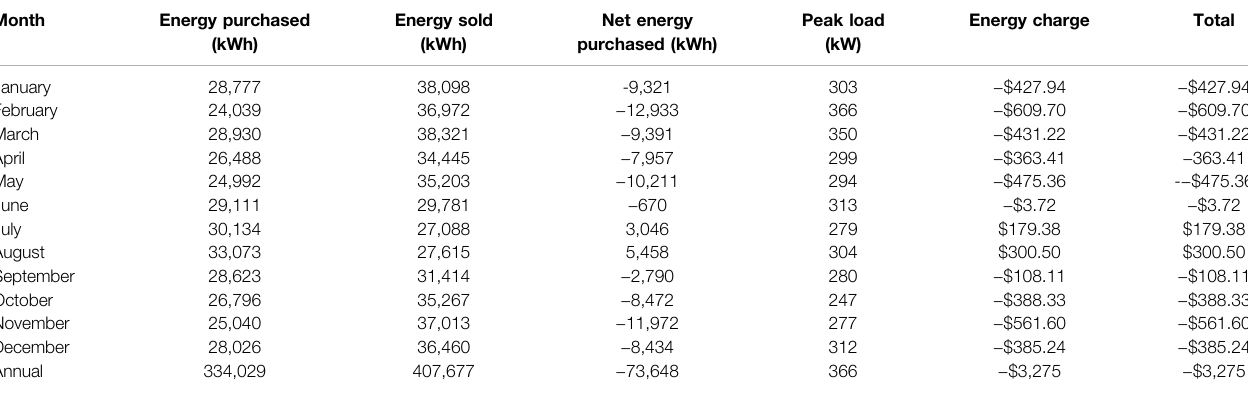
TABLE 10 | Grid energy fl ow and